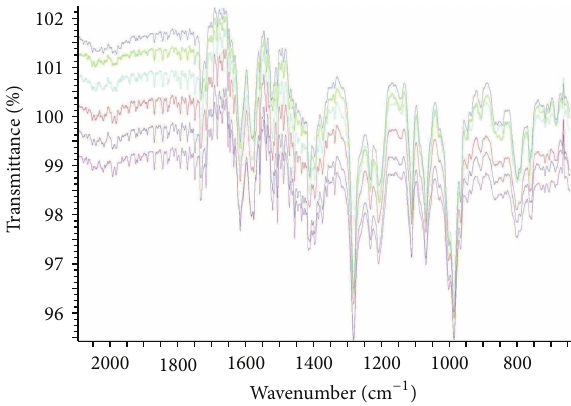
Figure 7: FT-IR spectra of unirradiated and gamma irradiated epidoxorubicin.